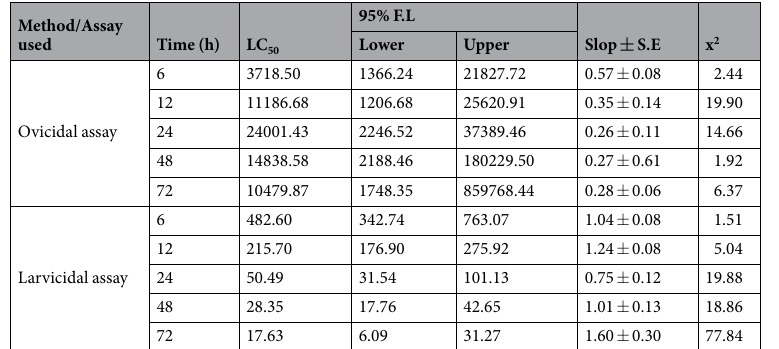
Table 5. Toxicity of Snef1216 ( P. chrysogenum ) against M. incognita by ovicidal and larvicidal assay.